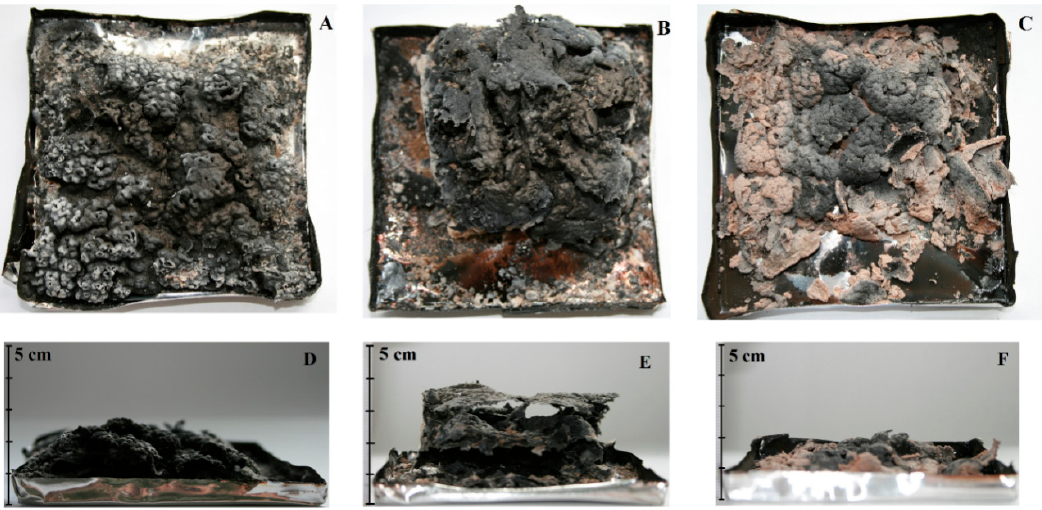
Figure 9. Photographs of selected materials after a cone calorimetry tests: 35 wt % WS ( a , d ), 35 wt % HS ( b , e ), and 35 wt % SH ( c , f ).